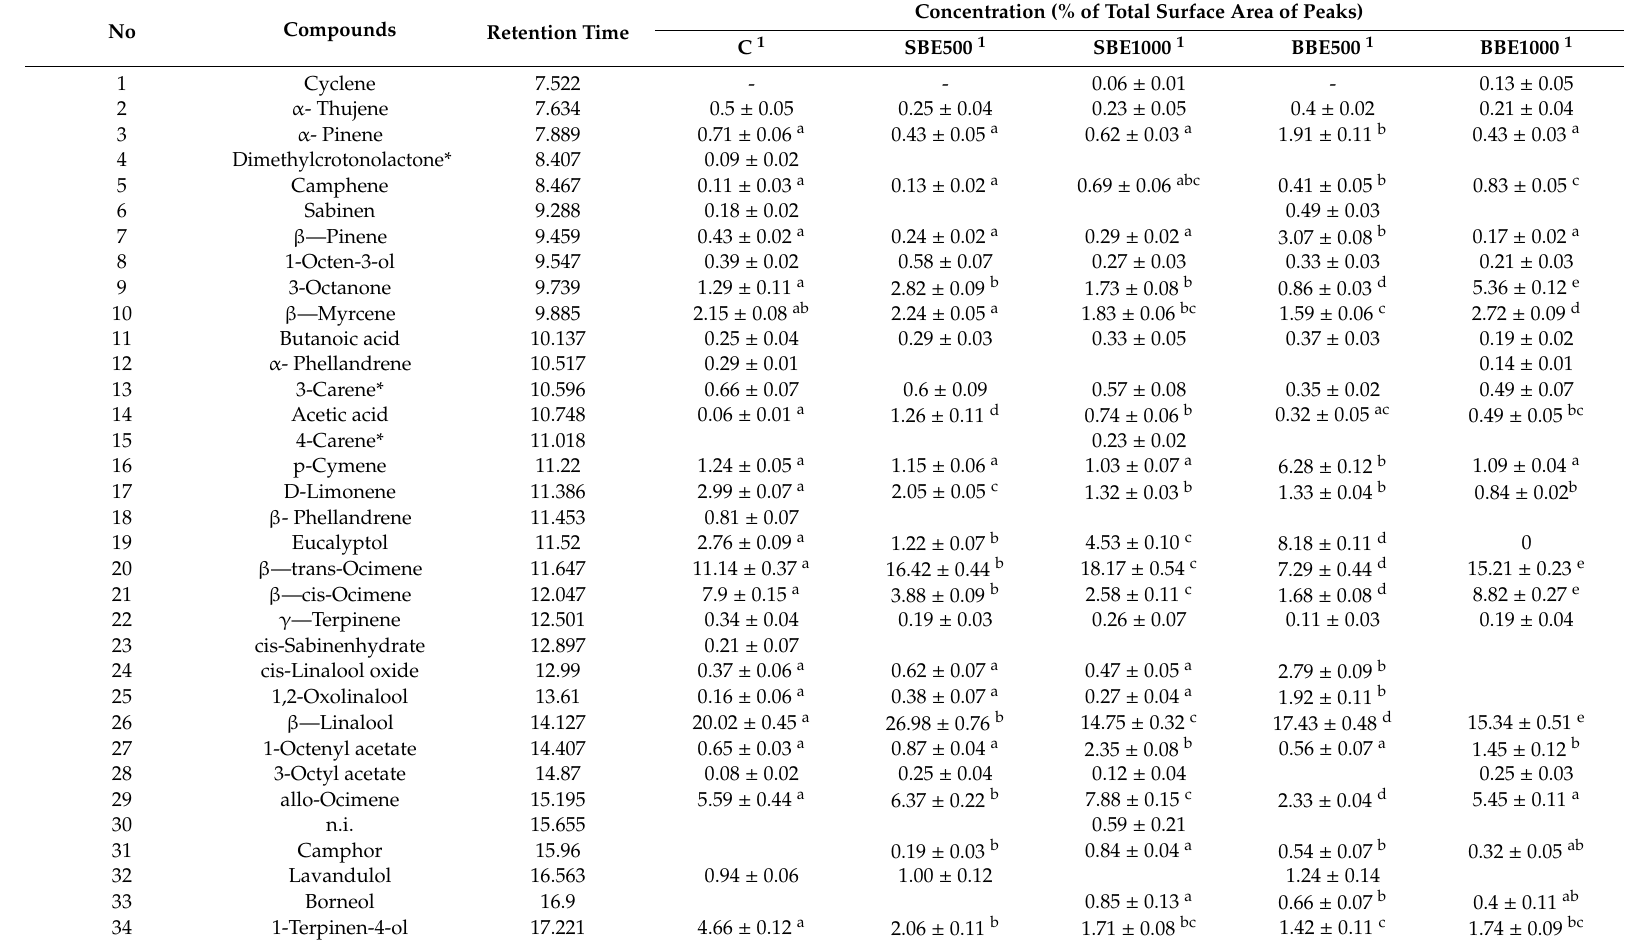
Table 4. Volatile oil composition of lavender